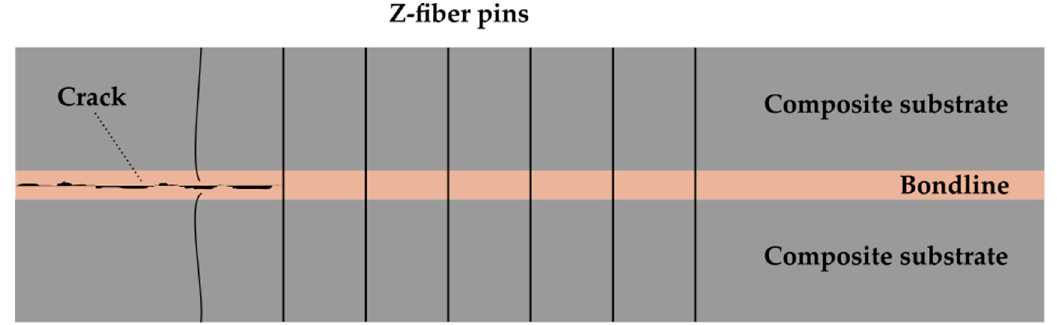
Figure 6. The concept of z-fiber pinning along the bondline.